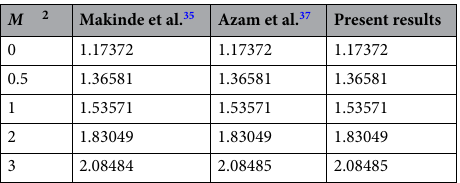
Table 1. Assessment of numerical computational results